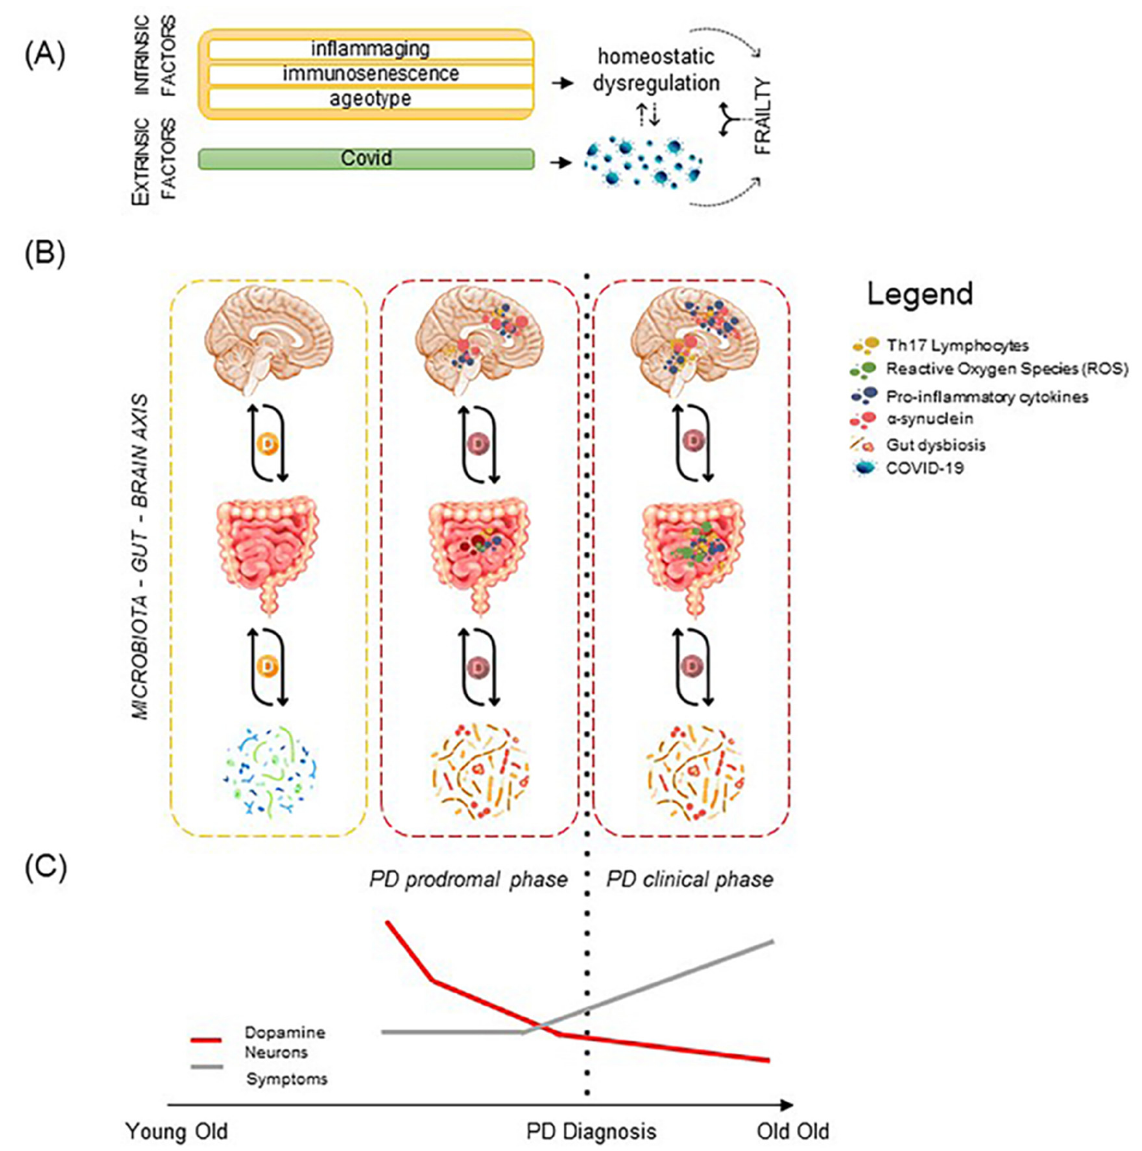
Figure 1. The complex interaction between inflammaging, immunosenescence and reduced microbiota diversity that accelerates the conversion from frailty to PD in the presence of SARS-CoV-2 infection is shown. The 3 panels should be read contextually. The pathological process is schematized in the continuum between the young–old (approximately 65–74 years of age) and the old–old (over age 85). Panel ( A ) Aging is influenced by multiple extrinsic and intrinsic factors leading to different phenotypes of the elderly. During the pandemic, multi-organ homeostatic dysregulation typical of old age was associated with the effects of viral infection, accelerating and exacerbating the processes of frailty. Frailty—in turn—contributed to aggravating both the consequences of COVID-19 infection and homeostatic dysregulation Panel ( B ) Overview of the microbiota-gut–brain axis related to the previous vicious circle that contribute to the PD occurrence. Panel ( C ) Schematic representation of the prodromal and clinical symptomatology of Parkinson’s disease over from adulthood to old age and the relative PD trajectories with respect to the relationship between dopaminergic cell depletion and manifest disease phenotype with reference to the microbiota-gut-brain axis alterations shown in panel ( B ). The current clinical diagnosis of PD is based on characteristic motor phenotypes that occur in advanced stages of the disease. These are preceded by prodromal symptomatology that manifests years to decades earlier, during middle age, but is less specific and varies greatly in timing and features among individuals.